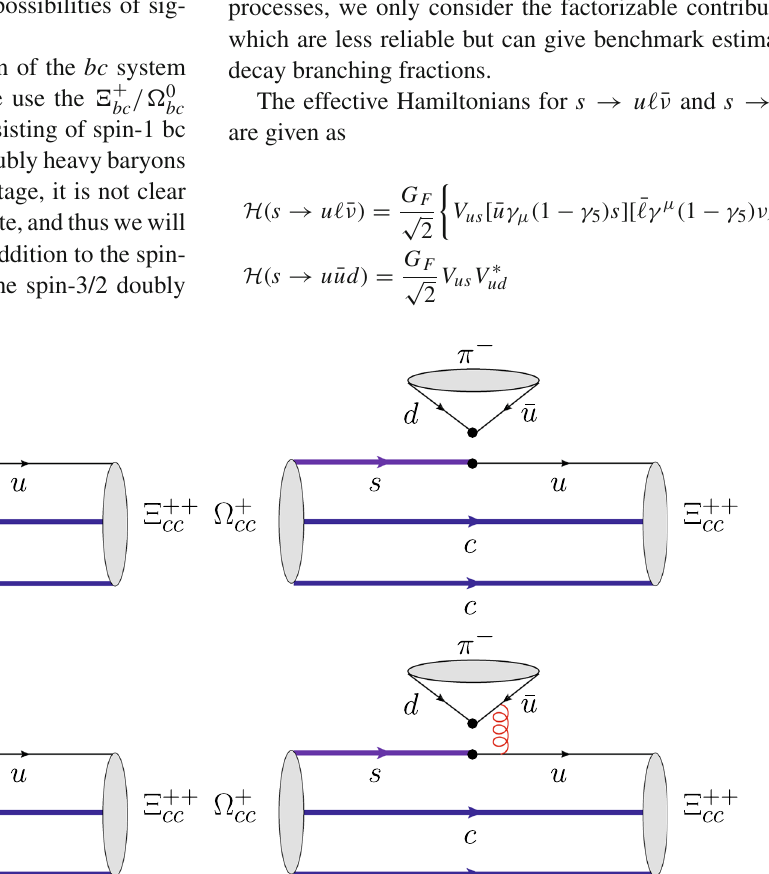
factorizable Feynman diagrams for the nonleptonic decay modes. In these panels, black dots correspond to the effective